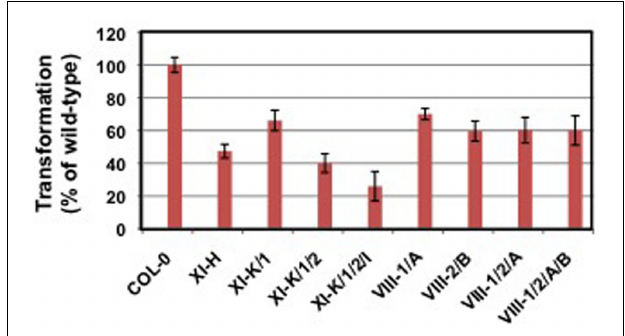
FIGURE 3 |Transformation susceptibility of myosin mutant Arabidopsis plants. Root segments of wild-type (Col-0) and mutant plants were infected with the tumorigenic strain A. tumefaciens A208 at a concentration of 10 6 cfu/ml.Tumors were scored 30days later. Data courtesy ofYanjunYu.